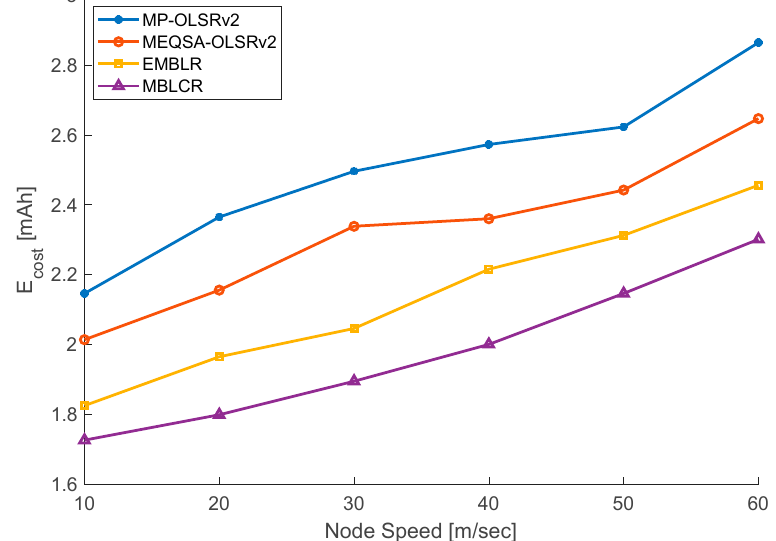
Figure 10. Energy cost with various device speeds.